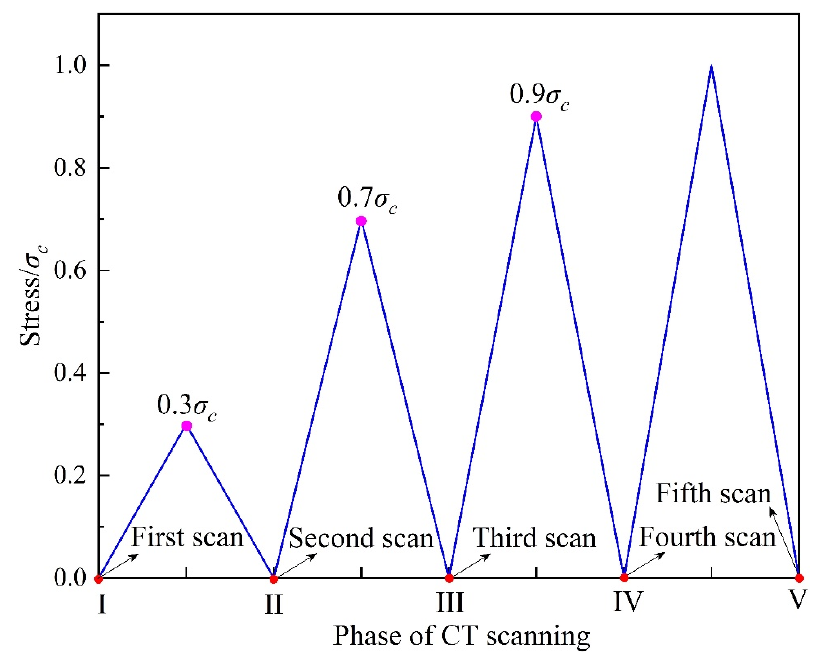
Figure 5. Schematic diagram of the cyclic loading and unloading process and CT scanning points. Each time, the specimen was loaded to a predetermined intensity value and then unloaded to 0, the CT scan was then performed, and so on. The red dots show the CT scan